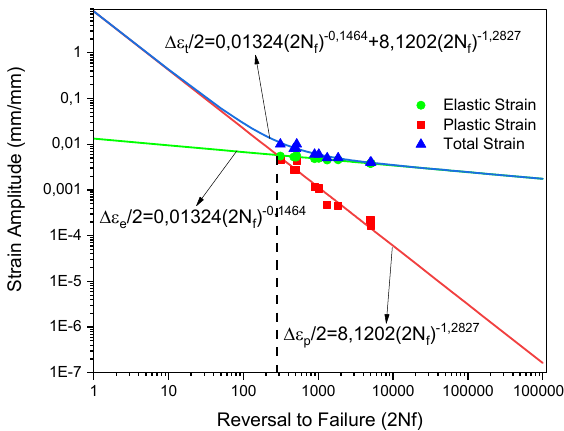
Figure 12. Strain amplitude curve vs. number of reciprocal fracture cycles